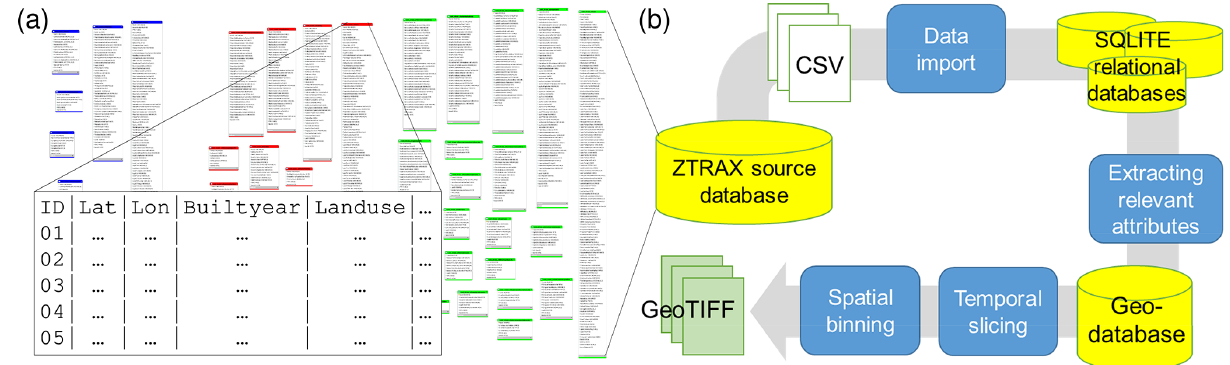
Figure 4. (a) Entity diagram illustrating the complexity of the ZTRAX data model, showing each database table and table attributes, and (b) generalized processing workflow to generate the BUPR, BUPL, and BUA surface series based on ZTRAX data records.